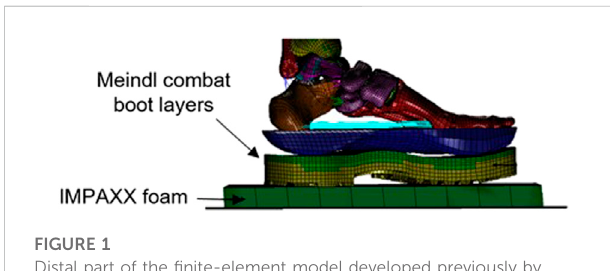
FIGURE 1 Distal part of the fi nite-element model developed previously